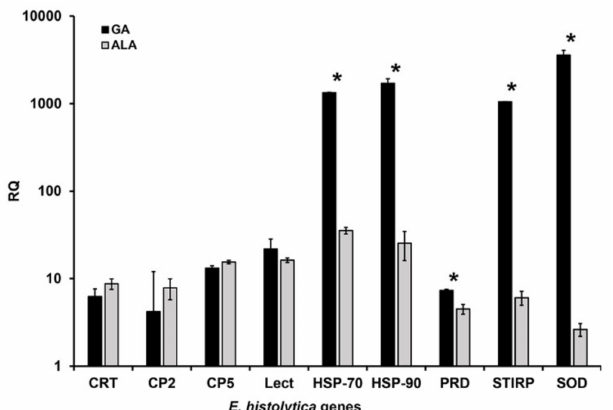
Figure 4. Relative quantification (RQ) of expression of genes of E. histolytica by RT-qPCR. Reverse transcription real time PCR was used to independently measure mRNA expression of Ehcp5, -cp2, -gal / galnac lectin, -crt, -stirp, -prd, -sod, -hsp-70 y 90 genes in trophozoites present in samples of tissue fragments from lesions of genital cutaneous amoebiasis (GA) and abscess drainage from patients with amoebic liver abscess (ALA). The values represent the mean of di ff erent patients for group. RQ di ff erences between the cDNAs obtained from samples of tissue fragments from lesions of GA patients and abscess drainage from patients with (ALA) were compared trough Student t tests, detecting statistical significance * ( p ≤ 0.05). Ehactin - α gen was used as housekeeping gene to normalize mRNA level. The individual dates are shows in the Supplementary Table